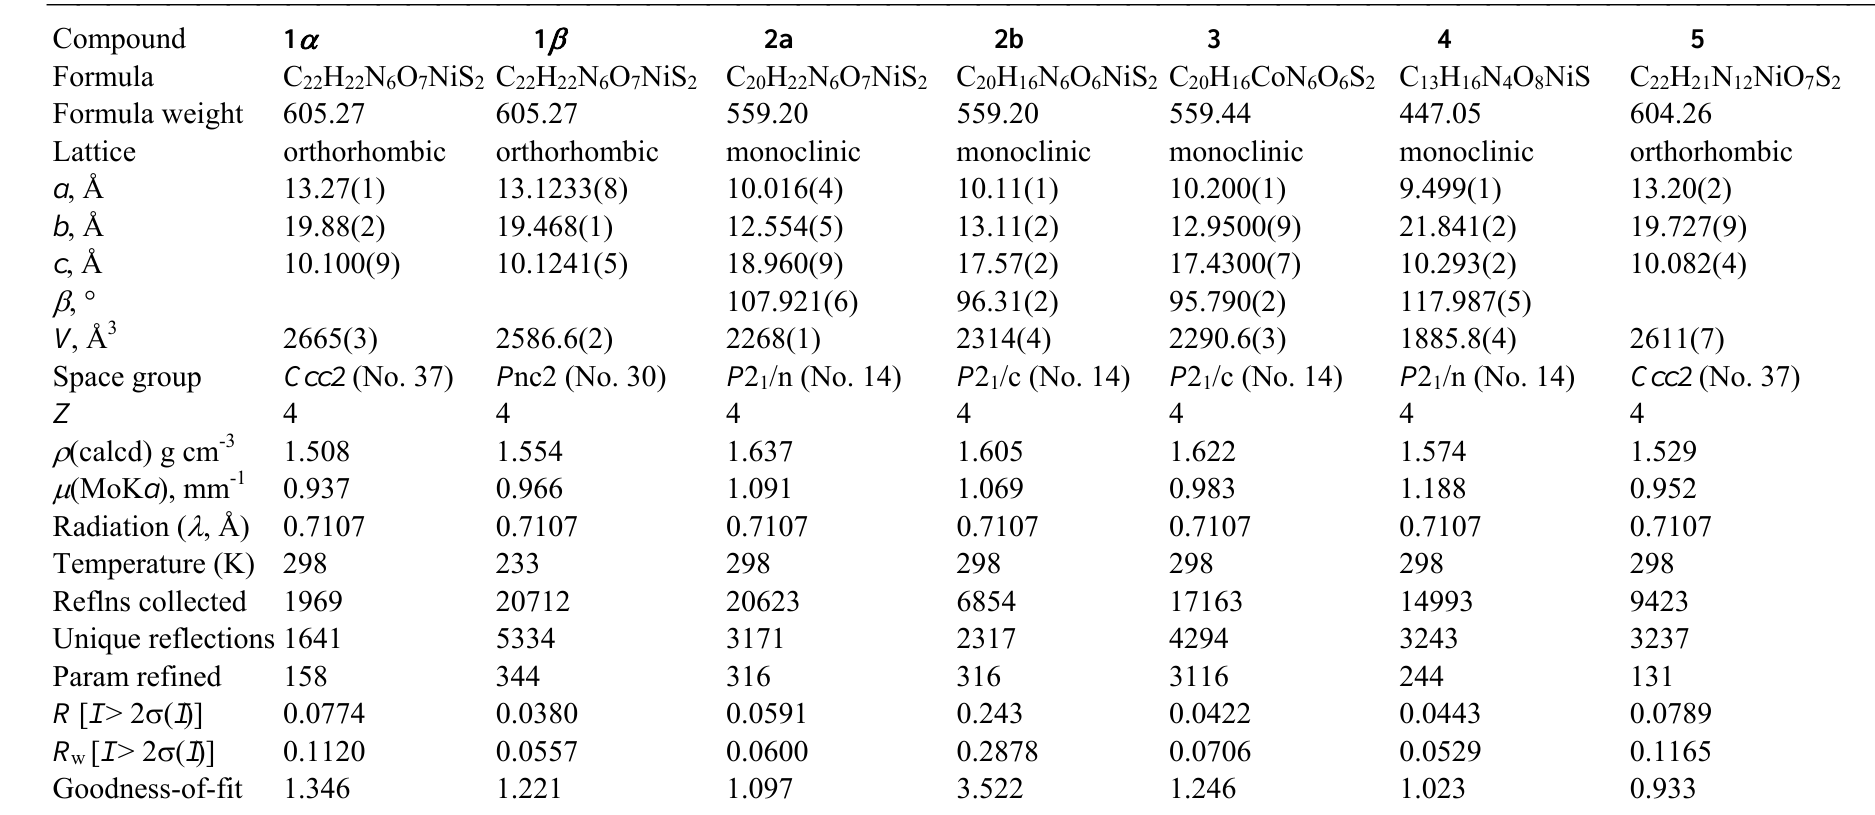
Table 1. Crystallographic Data for 1  , 1  , 2a , 2b , 3 , 4 , and 5